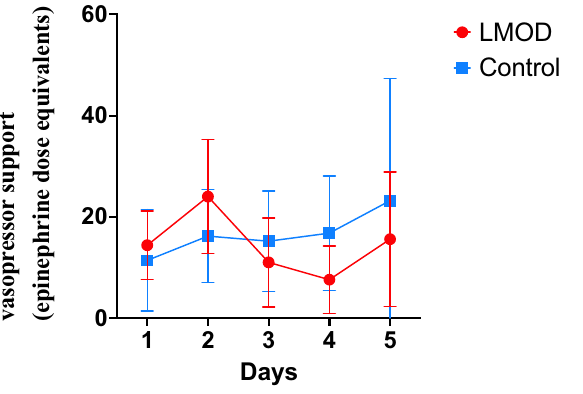
Figure 2. Primary outcome. Vasopressor support changes during the 5 days of follow-up. L-MOD patients are in red and control patients in blue. We showed a significant decrease of vasopressor drugs ( p = 0.02, Friedman test), and a trend to drugs dose for control patients.